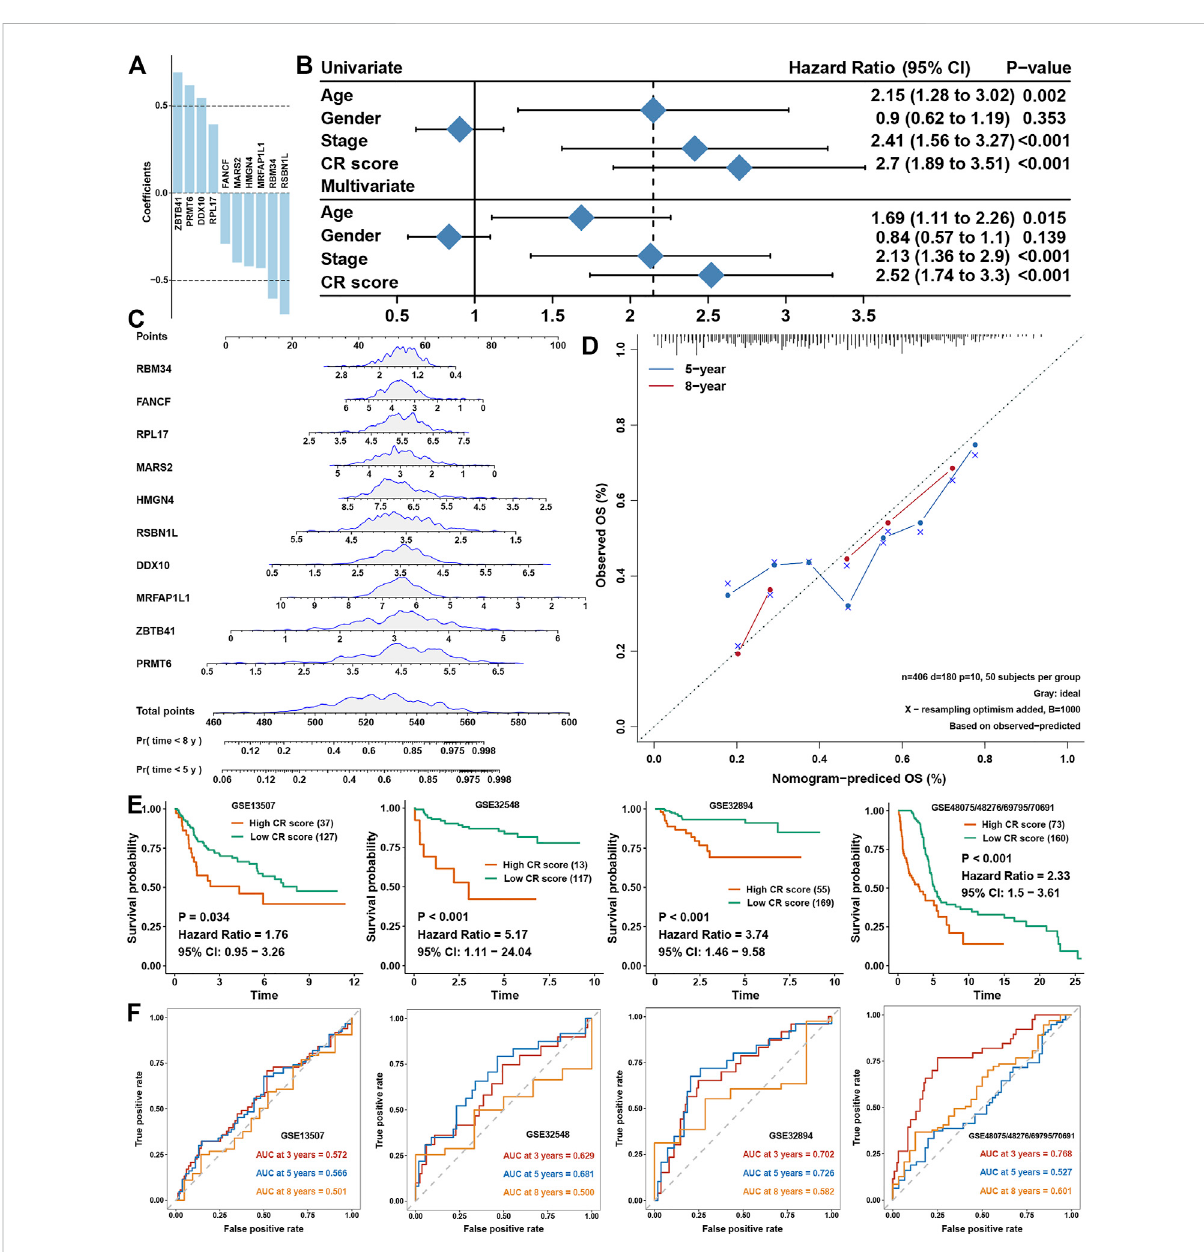
FIGURE 6 Validation of CR scores in BLCA (A) . Coef fi cients of members involved in the CR-scoring system (B) . Univariate and multivariate COX analyses for clinical traits and CR scores (C) . A nomogram to predict the 5-y and 8-y OS of BLCA (D) . The calibration curve for the nomogram model and the dashed diagonal line represents the ideal nomogram, the blue line and red line represent the 5-y and 8-y observed nomograms, respectively (E) . Validation of the CR scores in four external BLCA cohorts for overall survival (F) . ROC curves plotted for 3-, 5,- and 8-y OS of CR scores in the four external BLCA